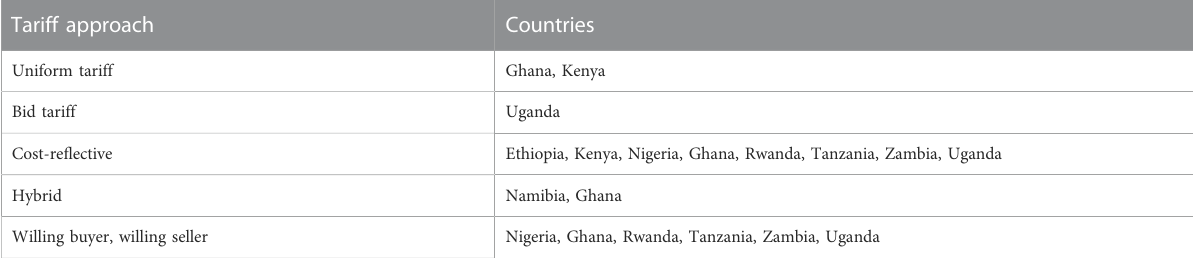
TABLE 9 Tariff strategies in Sub-Saharan Africa (Léautier,